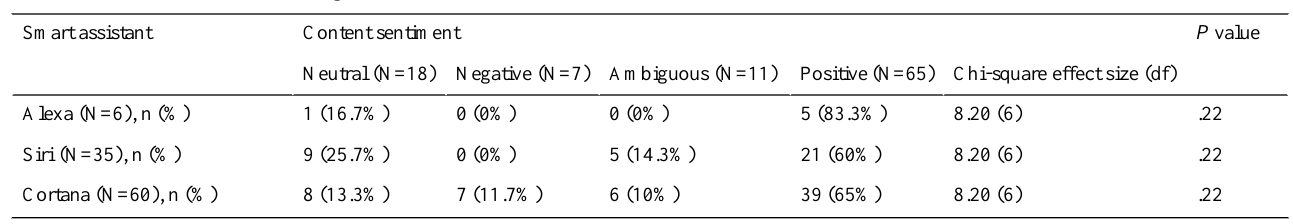
Table 4. Sentiment differences among the smart